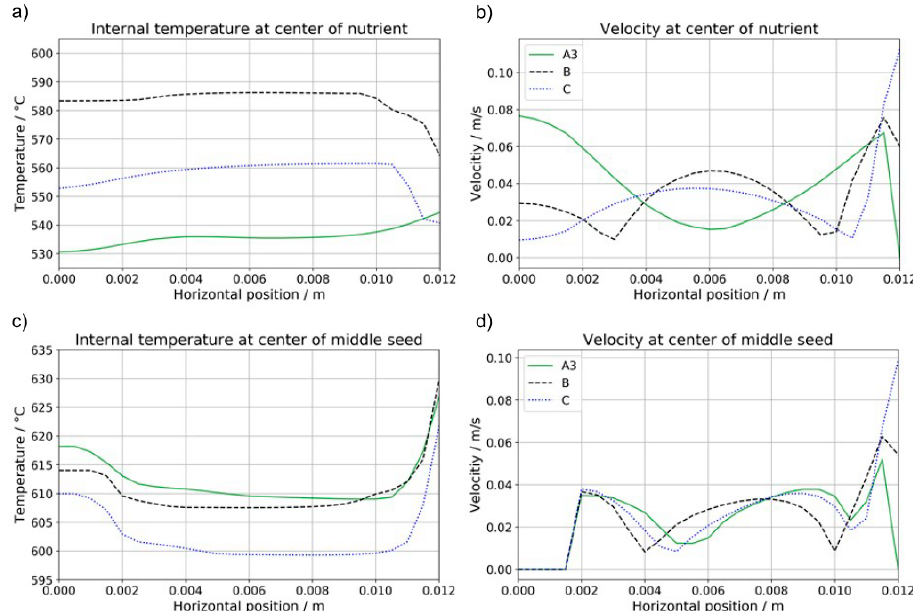
Figure 12. Comparison of internal temperatures ( a , c ) and flow velocities ( b , d ) depending on the method of boundary condition definition in radial direction at the center of the nutrient ( a , b ) and at the center of the middle seed ( c , d ). Regions with zero velocity originate from fully blocking solids.